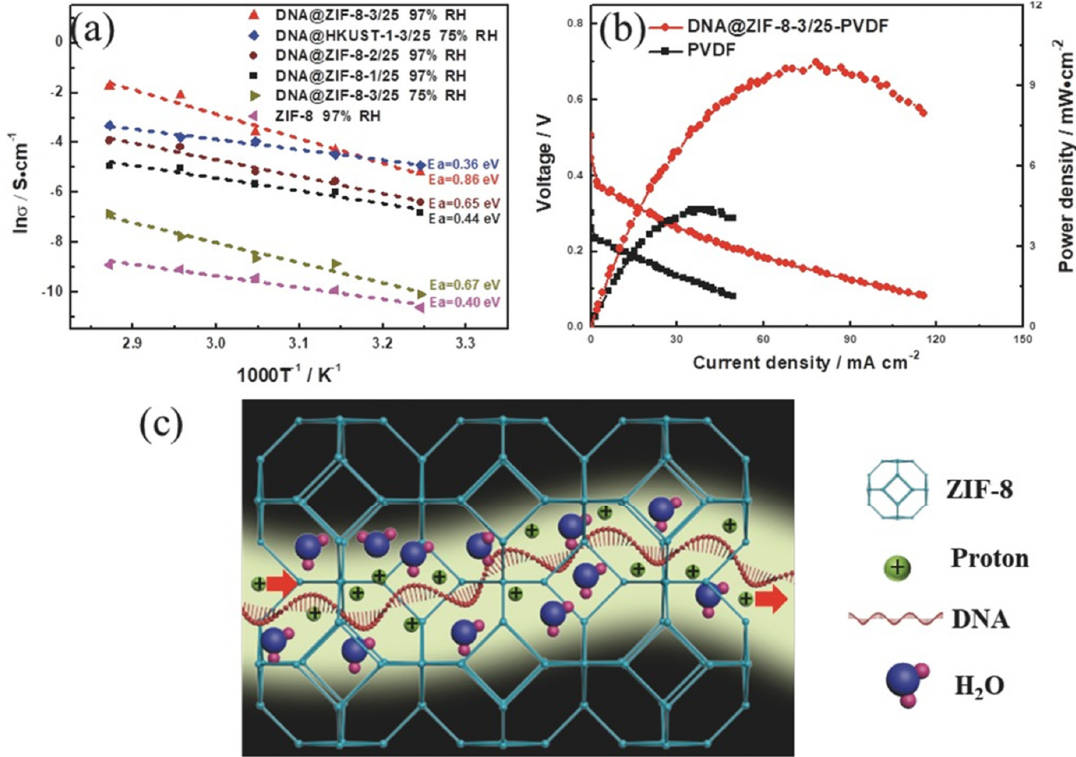
Figure 29. ( a ) Arrhenius plots of the membranes. ( b ) Polarisation curves and power densities of the semi-passive direct methanol fuel cells (DMFCs) using the membranes in 1.0 m methanol at 80 °C. ( c